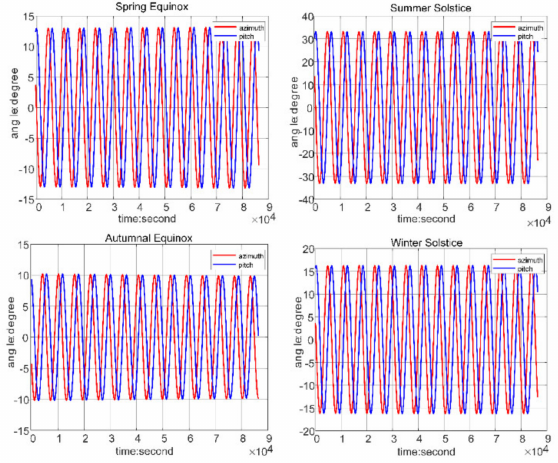
Figure 5. Azimuth and pitch angle